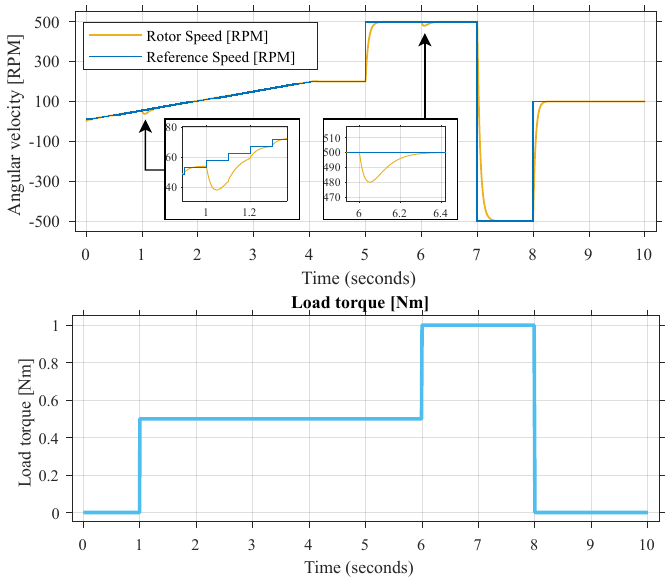
Figure 13. Rotor speed and load